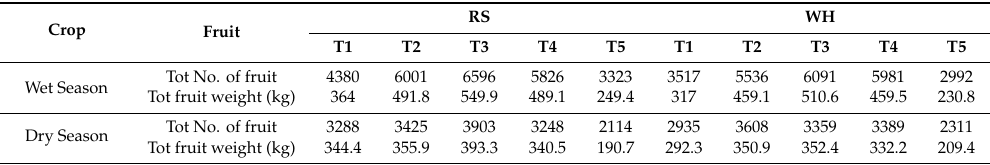
Table 5. Final yield (number of fruits or kg wet weight per treatment) of cucumber vegetable production in the integrated fish–farming system in each treatment and crop cycle. RS WH Crop Fruit T1